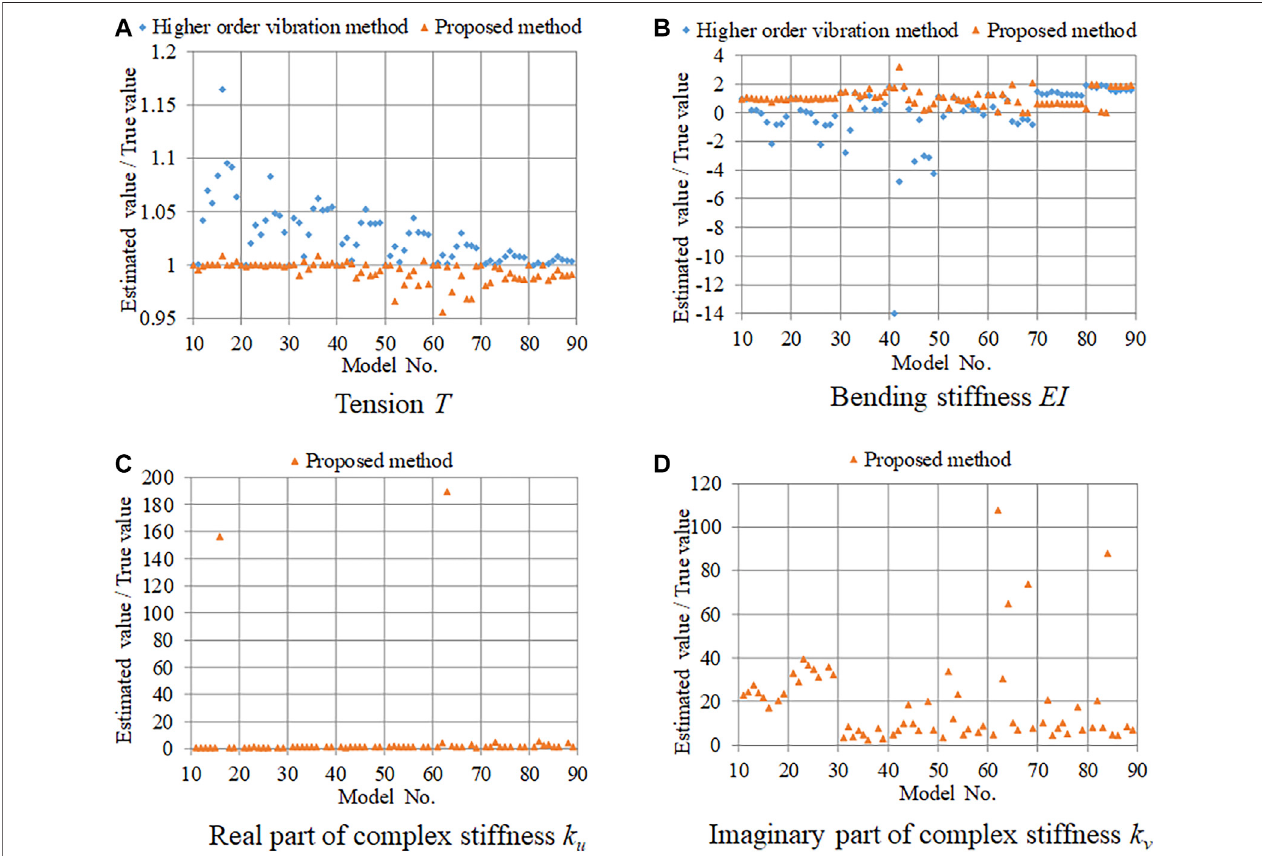
FIGURE 3 | Estimation accuracy of high-damping rubber damper model: (A) tension; (B) bending stiffness; (C) real part of complex stiffness; (D) imaginary part of complex stiffness.